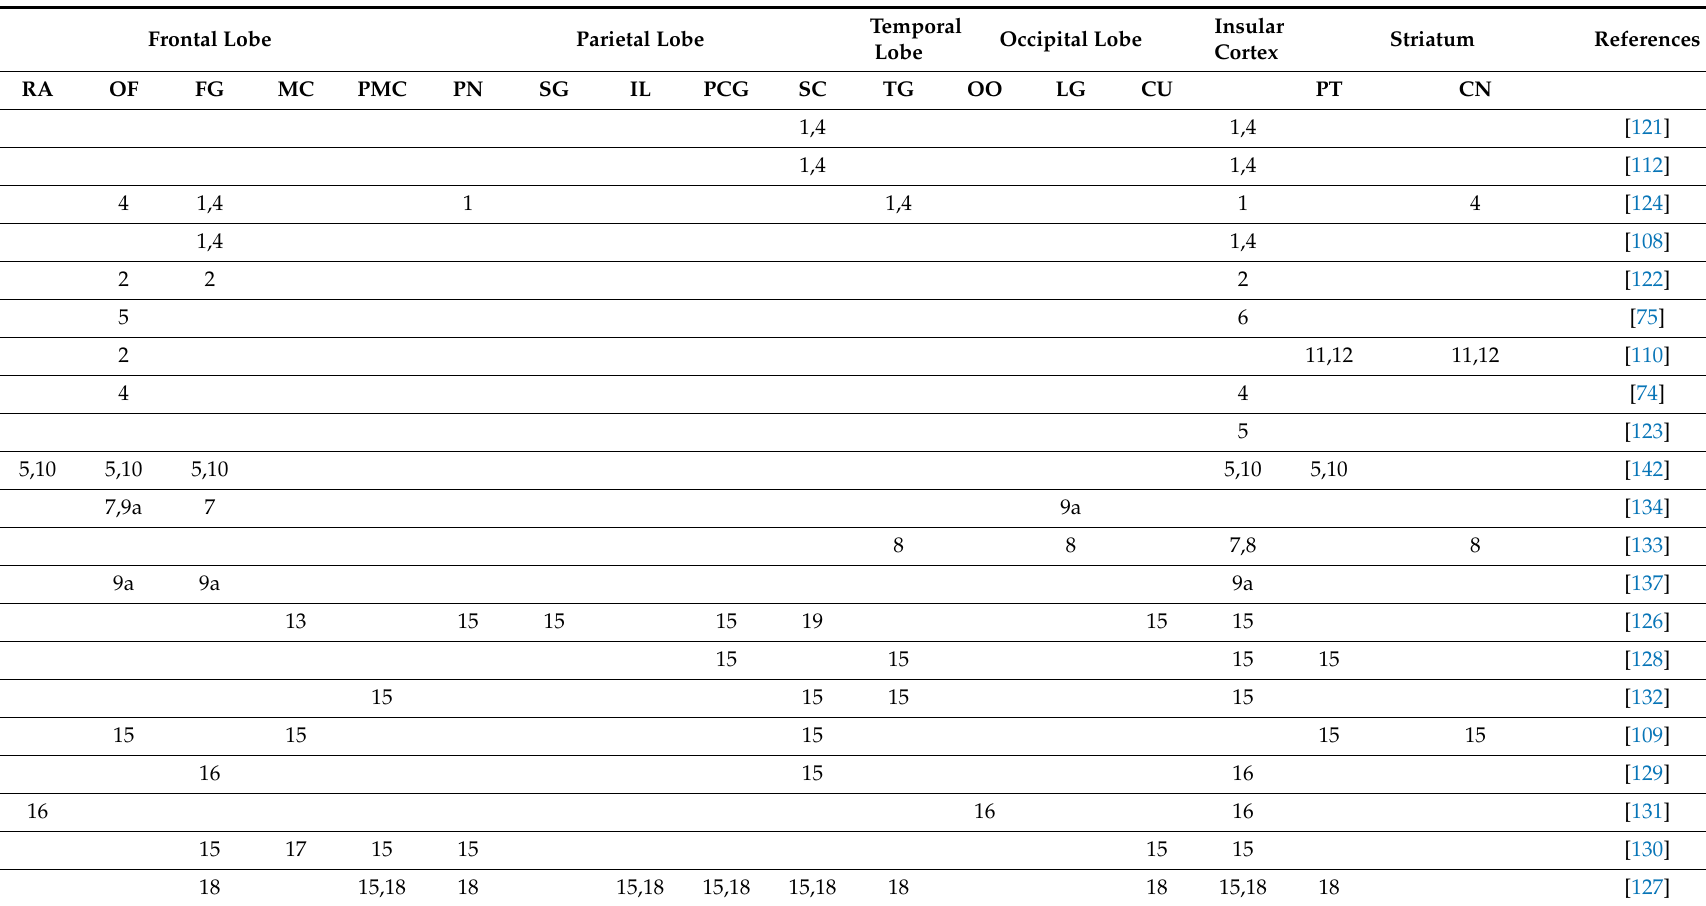
Table 6. Proposed functions of human neural networks and concurrently activated brain regions and loci.